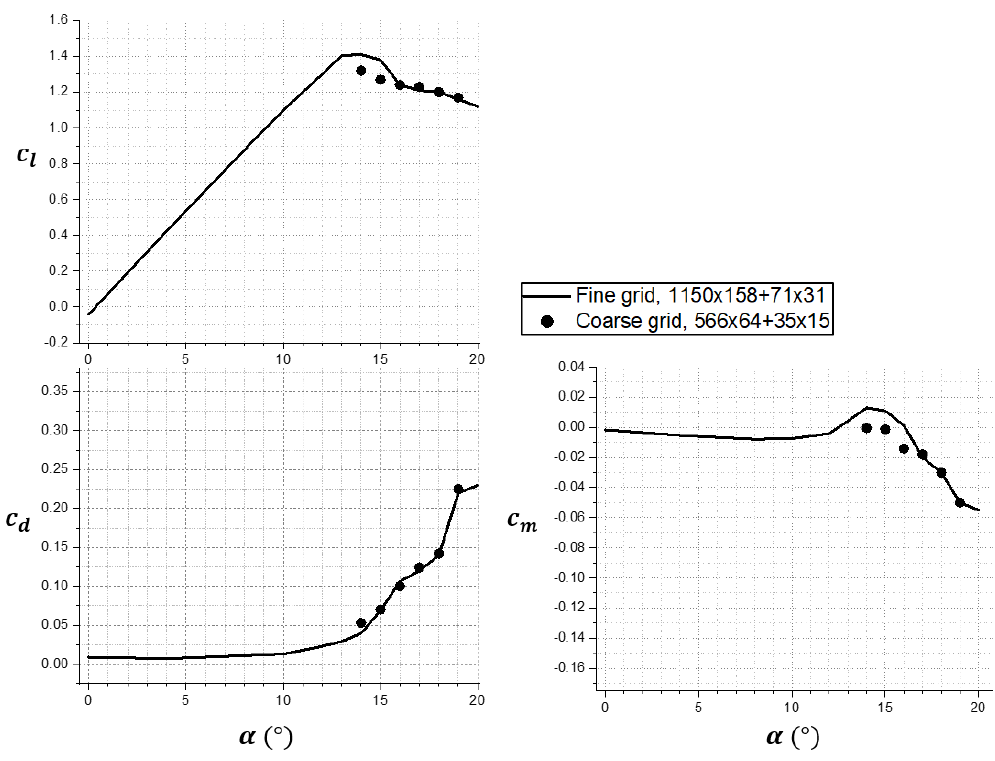
Figure 12. Comparison of two grids for the tangential jet